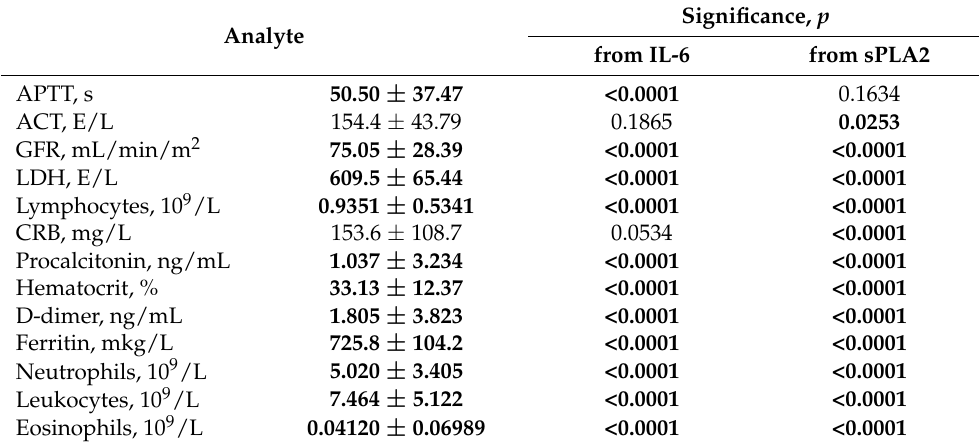
Figure 2 . IL-6 ( A ) and PLA2 ( B ) levels in patients depending on the severity of the COVID-19 infec- tion according to CT data. The numbers 0, 1, 2, and 3 indicate the degree of lung damage according Table 3. Laboratory analyte levels depending on the IL-6 and PLA2 concentration. to CT. The results are presented as medians and confidence intervals. The significance levels evalu- ated as * p < 0.05; ** p < 0.01; *** p < 0.001; and **** p < 0.0001